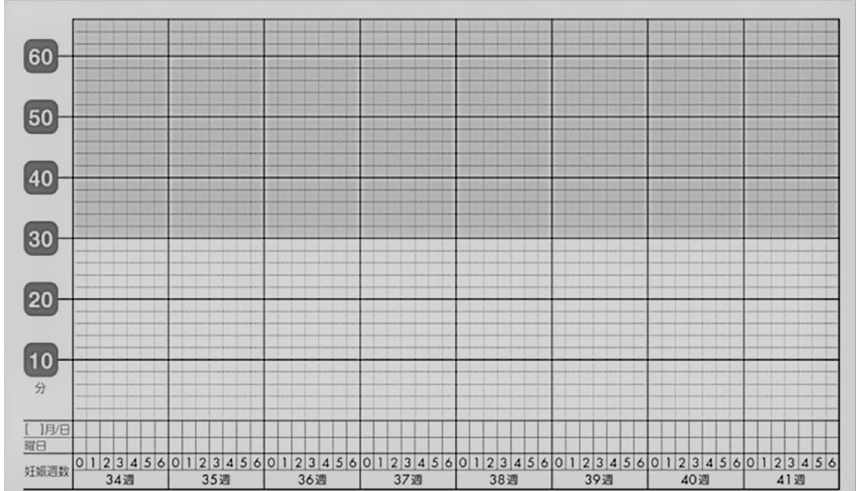
Figure 2. Fetal movement counting chart. Pregnant women were asked to record the time taken to perceive 10 fetal movements from 34 weeks of gestation, and also asked to report if it took more than 30 min to perceive 10 fetal